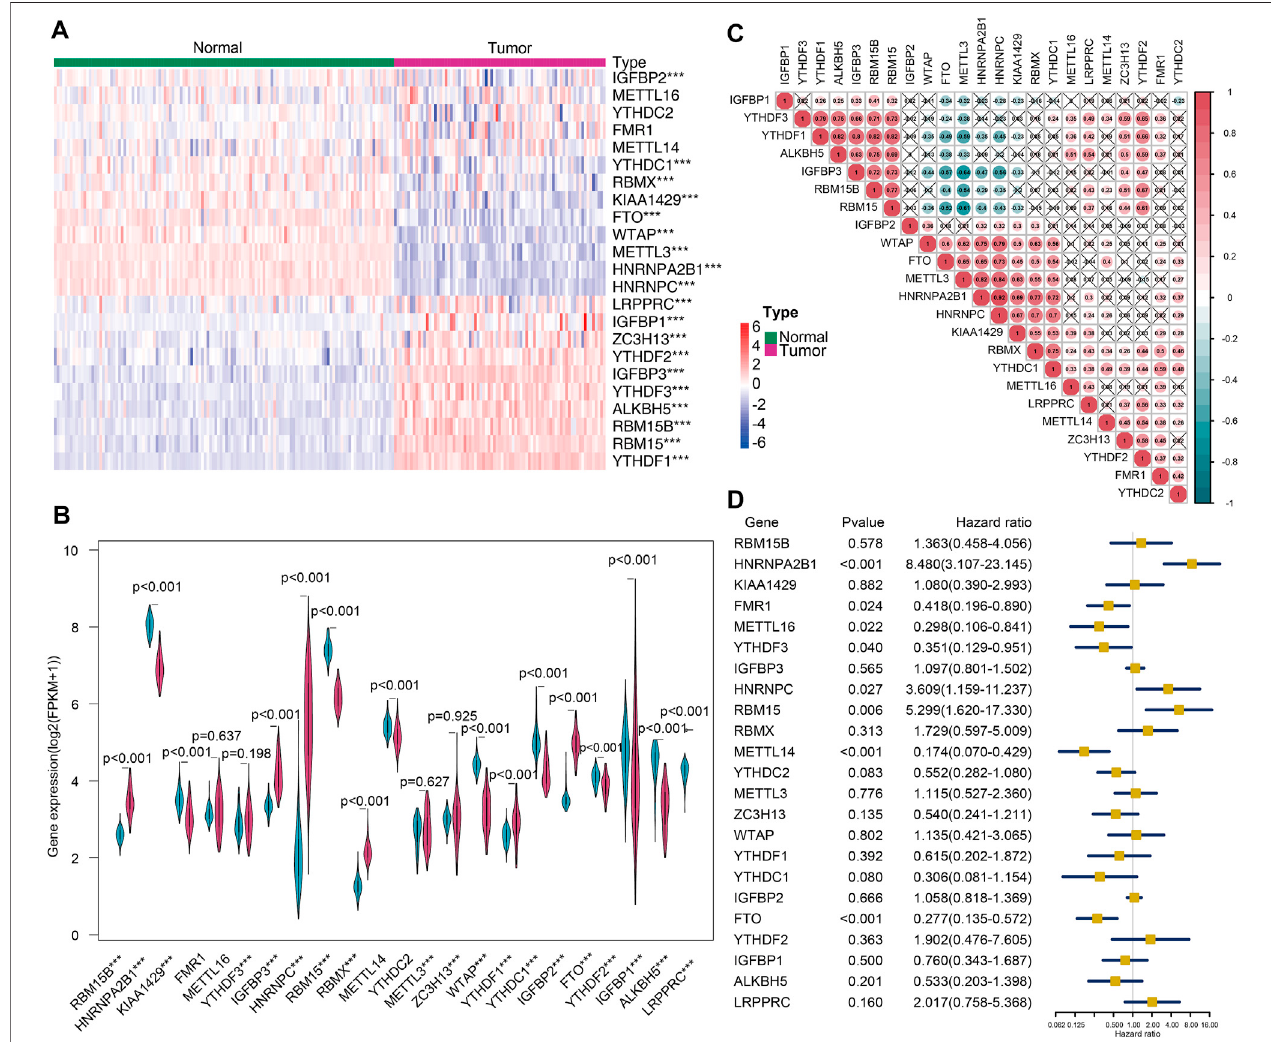
FIGURE 1 | The landscape of m6A-related regulators of ACC. (A) Heatmap showing the differential expressions of m6A-related modulators between 79 tumors and127normaltissues(*** p < 0.001). (B) Violinplotshowingthedifferentiallyexpressedregulators. (C) Thecorrelationbetweenthem6Amodulatorygenesinthecohort (×p > 0.05). (D) Forest plot depicting the prognostic capability of the 21 m6A-related modulators for ACC.